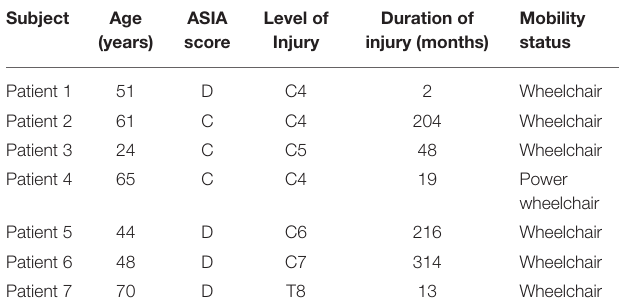
TABLE 1 | Patients participating in the